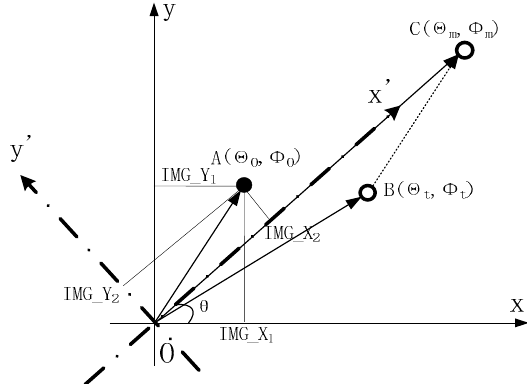
Figure 4. Projection diagram of boresight error and target position. Point O is the center point of the image detector and the target closed-loop point. A ( Φ 0 , Θ 0 ) is the imaging point of the target on the detector, which is the boresight error of the target. B ( Φ t , Θ t ) represents the target guiding position, and C ( Φ m , Θ m ) represents the target position synthesized by points A and B, which is the actual guiding position of the target.